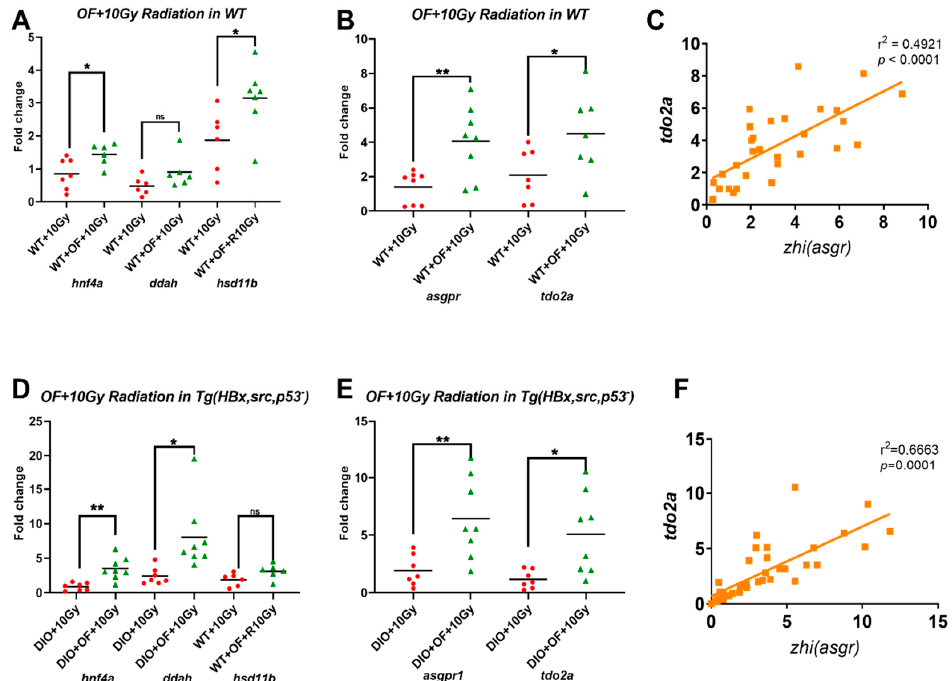
Figure 9. Upregulations of hnf4a , ddah1 , 11b-hsd1 , asgpr1 , and hnf4a downstream target genes: tdo2a , in zebrafish after irradiation. ( A ) Gene expression profiles of hnf4a , ddah1 , 11b-hsd1 and ( B ) zhi (asgpr1) , tdo2a in WT zebrafish irradiation (WT + 10 Gy) and Oligo-Fucoidan pretreatment (WT + OF + R). ( C ) Positive correlations between zhi ( asgpr1 ) and tdo2a were shown. ( D ) Gene expression profiles of hnf4a , ddah1 , 11b-hsd1 and ( E ) zhi (asgpr1), tdo2a in HBx,src,p53-transgenic fish with diet-induced obesity plus 10 Gy irradiation (DIO + 10 Gy) or treatment of Oligo-Fucoidan before 10 Gy irradiation (DIO + OF + 10 Gy). ( F ) Positive correlations between zhi (asgpr1 ) and tdo2a were shown. Statistical significance was calculated by t -test ( * p ≤ 0.05, ** p ≤ 0.01, *** p ≤ 0.001).